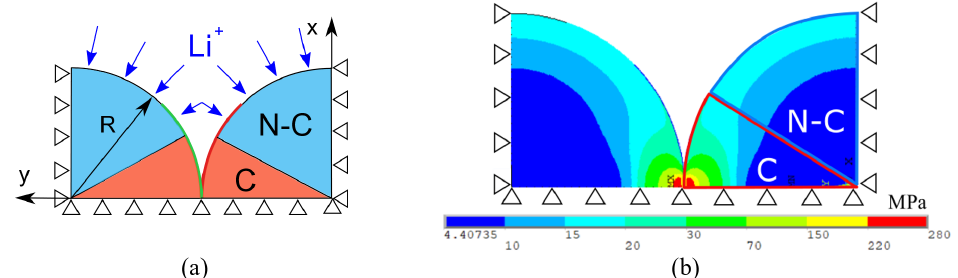
Figure 4. Sketch of the electrochemical-mechanical model, axisymmetric around y axis ( a ). Green and red lines are the conta172 and targe169 contact elements. Light blue arrows refer to the lithium flux applied to particles boundaries. Von Mises stress with lithium flux equal to 1 A/m 2 and t = 600 s shows contact (C) and non-contact (N-C) areas ( b